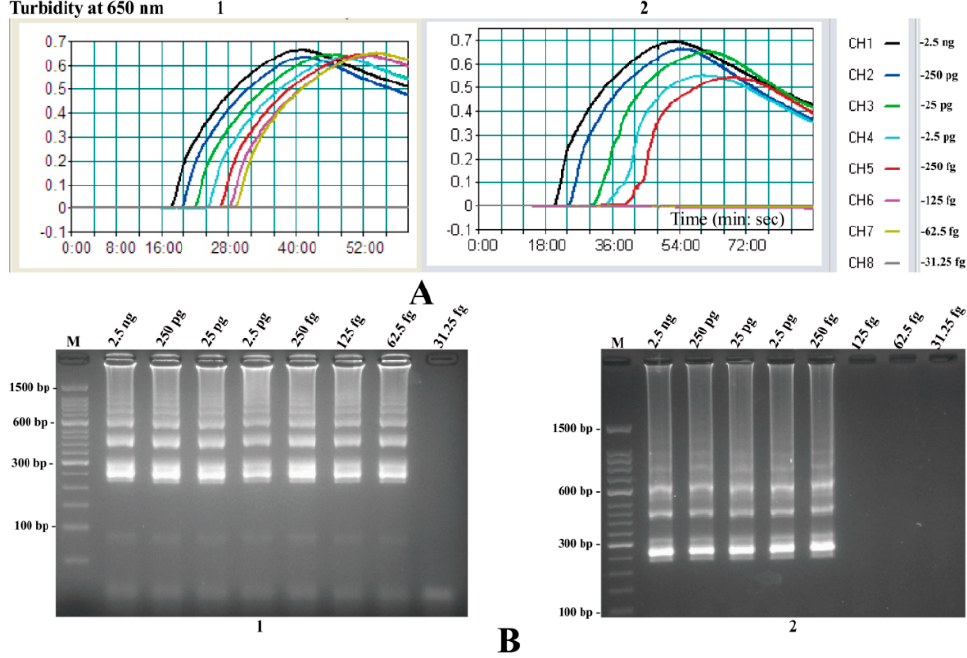
Figure 10. Sensitivity of the MIP-LAMP and nLAMP assays using serially diluted genomic DNA with L. monocytogenes strain EGD-e as template. A , Sensitivity of MIP-LAMP ( A1 ) and nLAMP ( A2 ) for L. monocytogenes detection was analyzed by real-time measurement of turbidity. The LoD for MIP-LAMP and nLAMP assays were 62.5 fg and 250 fg genomic DNA per reaction, respectively; ( B ), Sensitivity of MIP-LAMP ( B1 ) and nLAMP ( B2 ) approaches for L. monocytogenes detection were seen by gel electrophoresis, respectively. Lane M, DL 50-bp DNA marker. The positive results were observed as a ladder-like pattern on 2.5% agarose gel electrophoresis analysis.